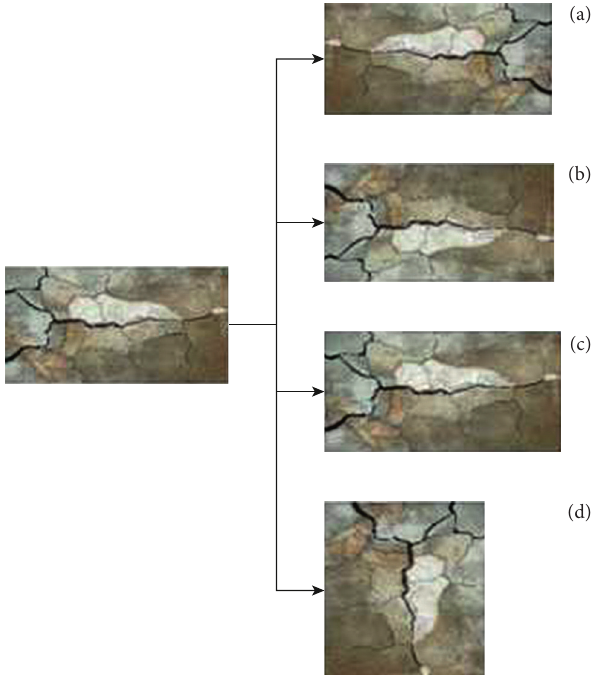
Figure 2: Augmented images: (a) horizontal flipping, (b) vertical flipping, (c) clipping, and (d)